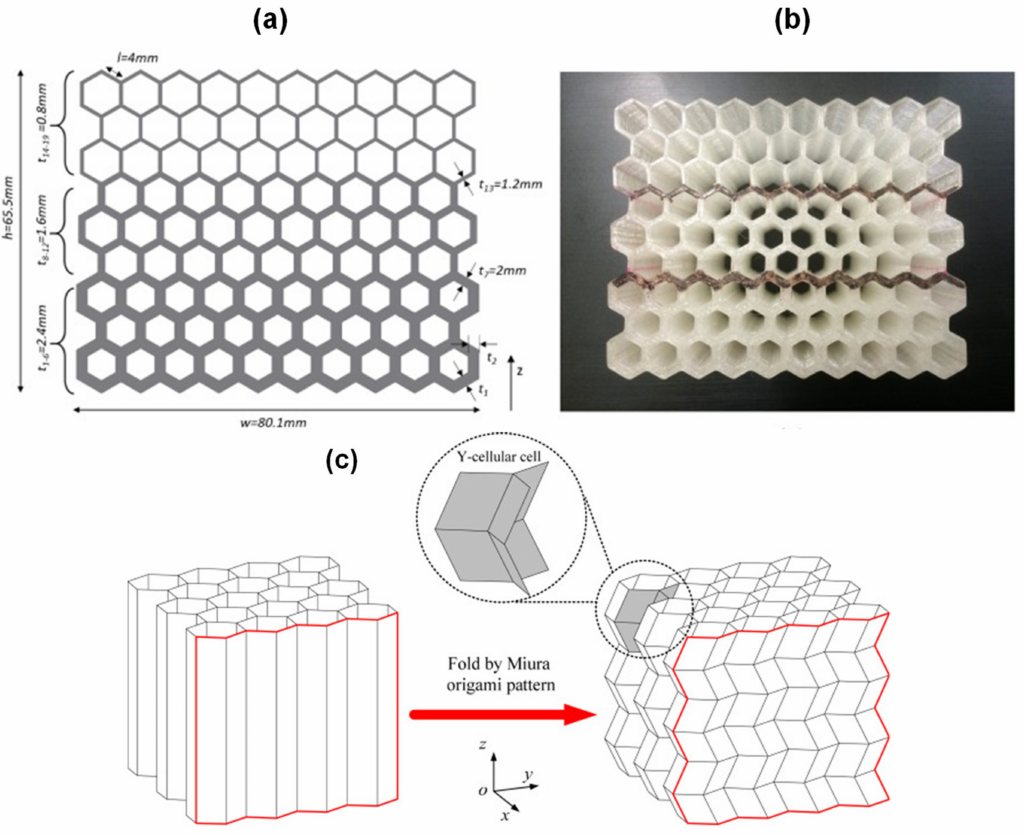
Figure 10. ( a ) Design details of 3 stage graded hexagon; ( b ) The test specimens produced by FFF 3D printing process [40]; ( c ) Plan used in the construction of pre-folded honeycomb